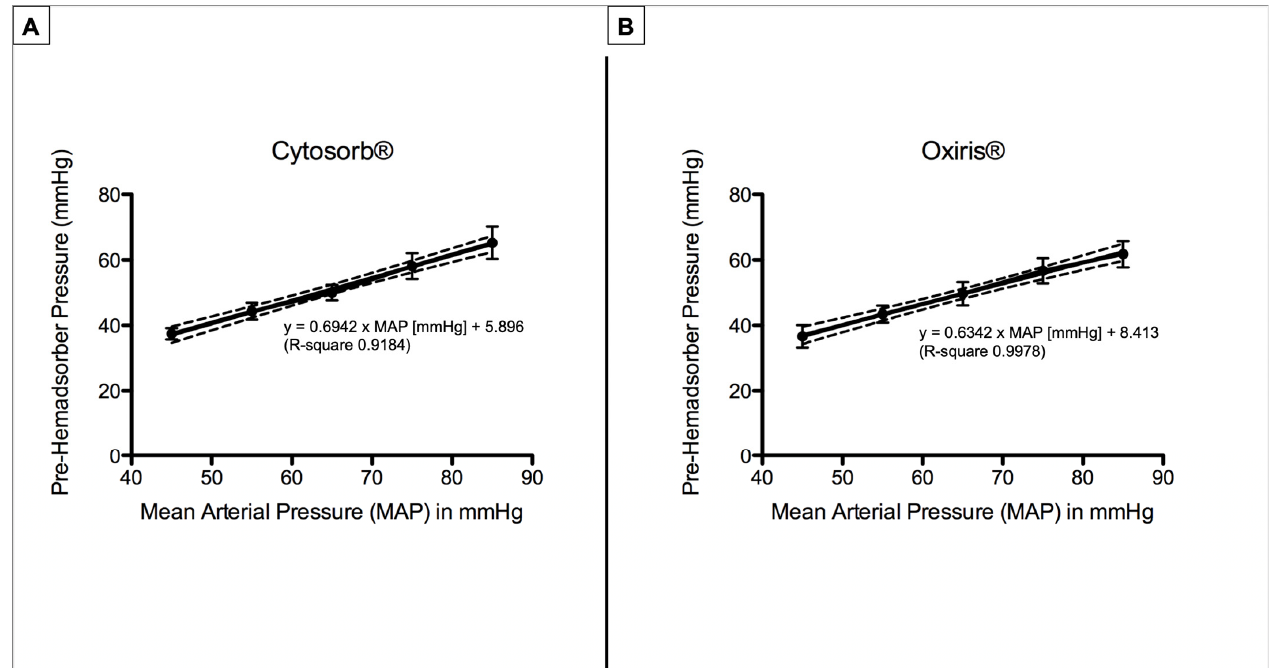
Figure 3. Pre-hemadsorber pressures for the CytoSorb ® ( A ) and Oxiris ® ( B ) devices. Mean pre- hemadsorber pressures linearly increased with stepwise increases in mean arterial pressure. Each figure depicts mean pre-hemadsorber pressure ± SD, as well as the linear regression line and their 95% confidence band of the best-fit line (scattered lines).